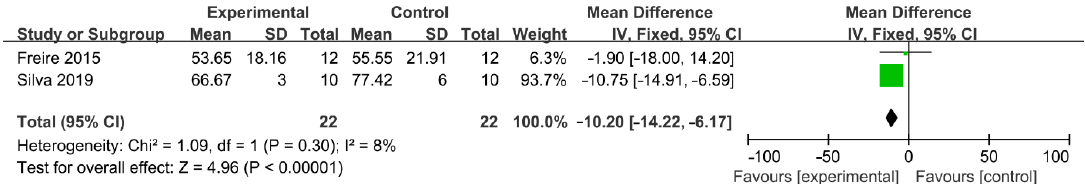
Figure 4. Forest plot and meta ‐ analysis of comparison between PUI and SNI [35–37,39,42].